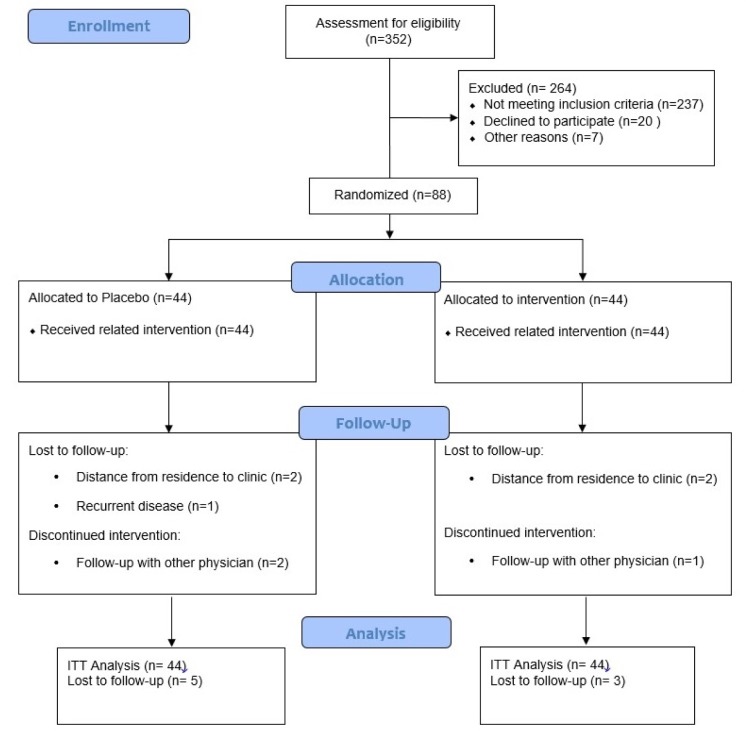
Consort diagram